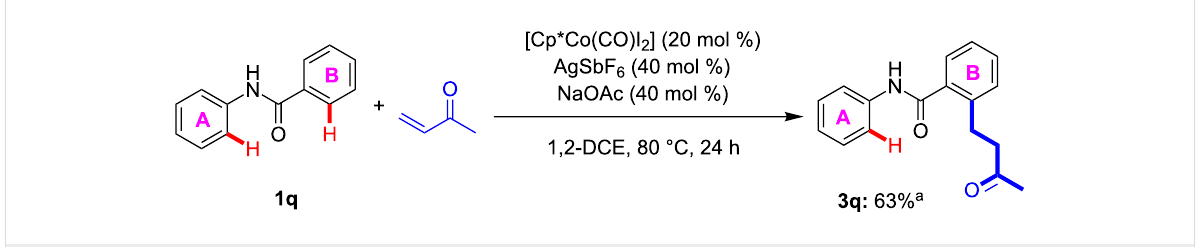
Scheme 4: Competitive experiment between coupling to acetanilide (ring A) or benzamide (ring B). a Major product 3q obtained after purification with inseparable traces of proposed acetanilide coupling product.